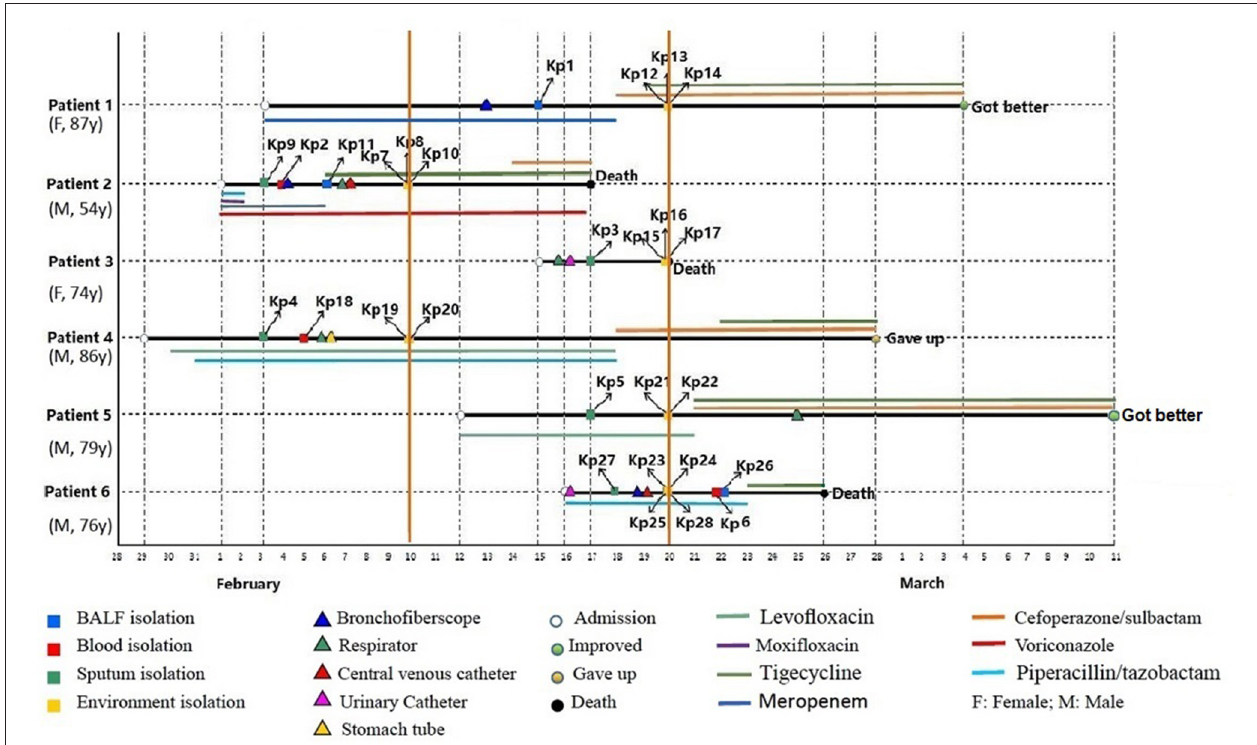
FIGURE 1 | Epidemiology of the CR-hvKP outbreak cases. Each horizontal line represents the timeline of one patient, with the abscissa axis showing the relevant dates. The isolates from different specimens and the traumatic treatment of these patients are represented by “ 2 ” and “ 1 ,” respectively. The outcome of the patients was represented by “O,” and the antibiotics used were represented by different color lines, and the length of the color lines represented the length of the antibiotic